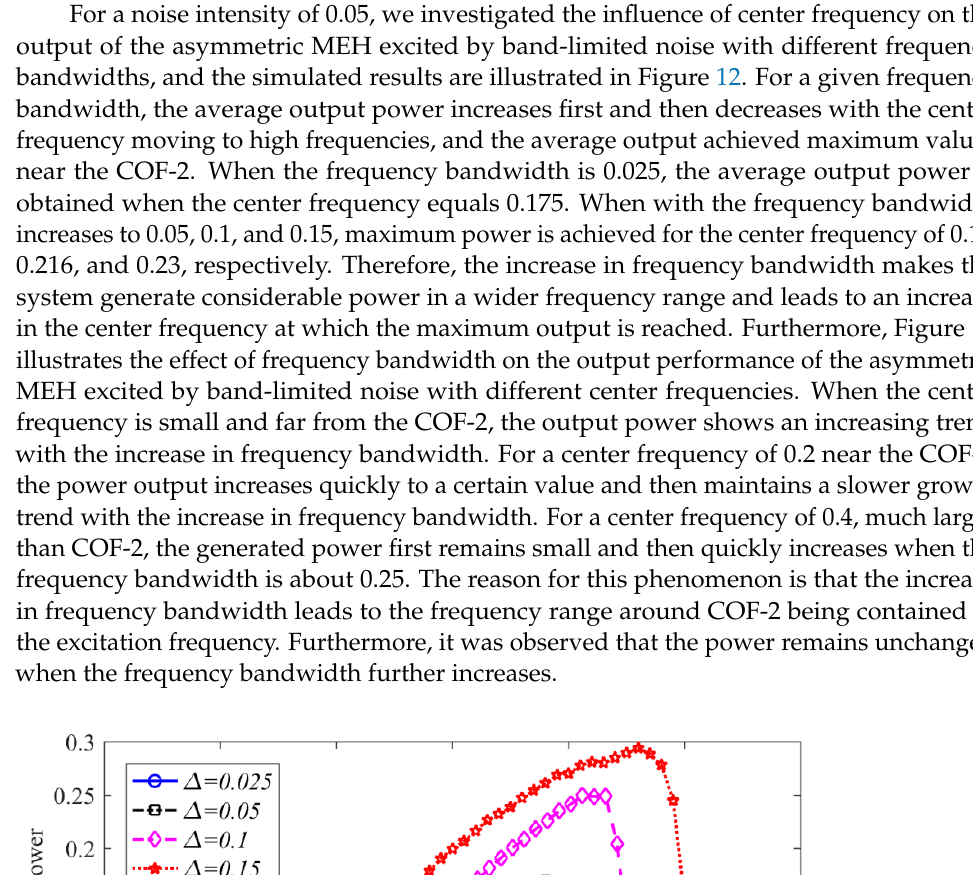
Figure 11. Influence of frequency bandwidth on the output performance of the asymmetric MEH excited by band-limited noise with different noise intensity (CF = 0.18).